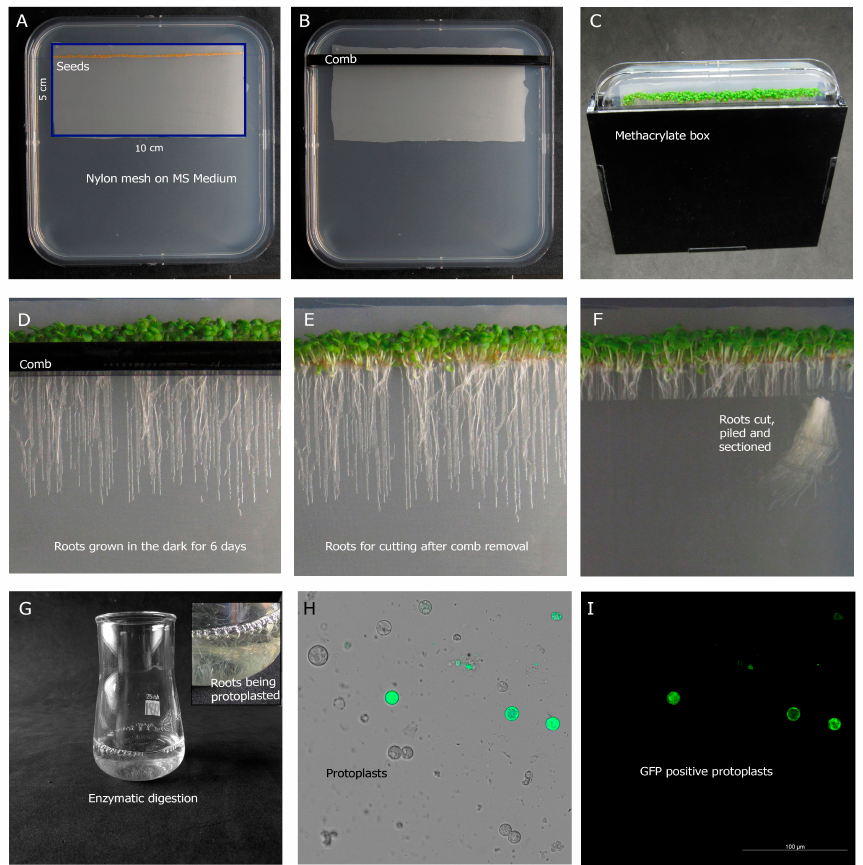
Figure 1. Procedure for seedling growth in the D-Root device, protoplasting, and microscopy analysis before fluorescent activated cell sorting (FACS). ( A ) After sterilization, fluorescent marker line seeds were sown in a row on a sterile Nitex mesh (5 × 10 cm). ( B ) A methacrylate comb was inserted into the agar. ( C ) The Petri dish was inserted into the methacrylate box and grown in standard long-day photoperiodic conditions at 22 °C for 6 days. ( D – F ) Removal of the metacrylate box, petri dish lid ( D ), and comb ( E ) prior protoplast processing. ( F ) Roots were cut 1 cm from the hypocotyl, piled, and sectioned into 3 pieces. ( G ) Root sections were collected and incubated with an enzyme mix solution in a small Erlenmeyer flask for 1 hour and 45 minutes. Inset: magnification of the Erlenmeyer flask showing root sections in solution. ( H , I ) Protoplasts were examined by fluorescence microscopy. ( H ) Merge of bright field and green fluorescent protein (GFP) settings. ( I ) GFP signal.